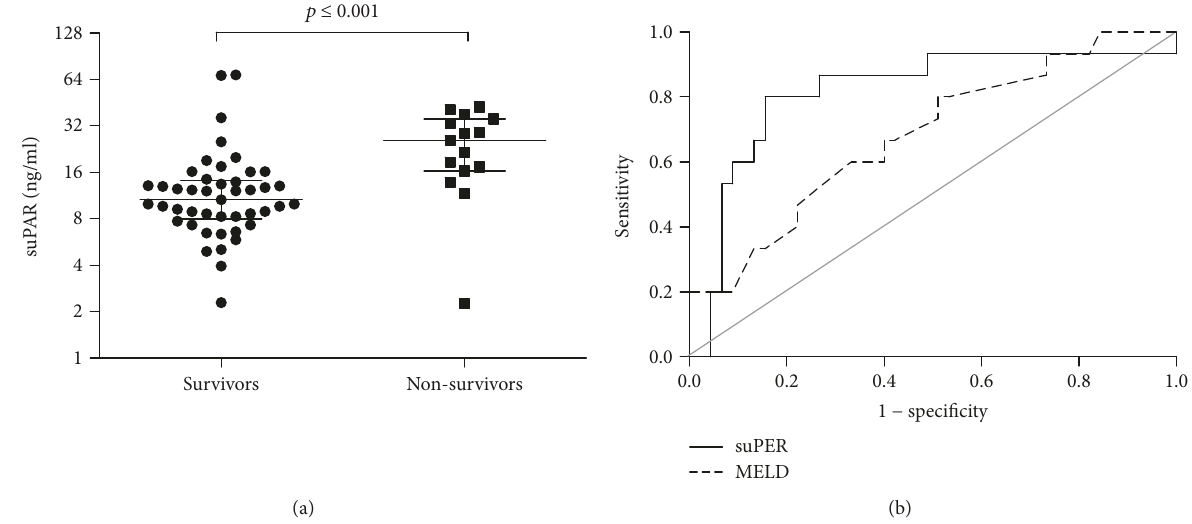
Figure 2: Serum suPAR level at baseline was associated with a 3-month mortality in HB-ACLF patients. (a) Baseline serum suPAR concentration is higher in survivors ( n = 45 ) than nonsurvivors ( n = 15 ) with hepatitis B-related acute-on-chronic liver failure. Values are expressed as median ± interquartile range. (b) Receiver operating characteristic (ROC) curves of suPAR and MELD score at baseline in HB-ALCF patients. Serum suPAR concentration at baseline has a stronger power for predicting unfavorable outcome as suggested by area under the curve ( AUC = 0 816 , p ≤ 0 001 ) than MELD score ( AUC = 0 682 , p = 0 036